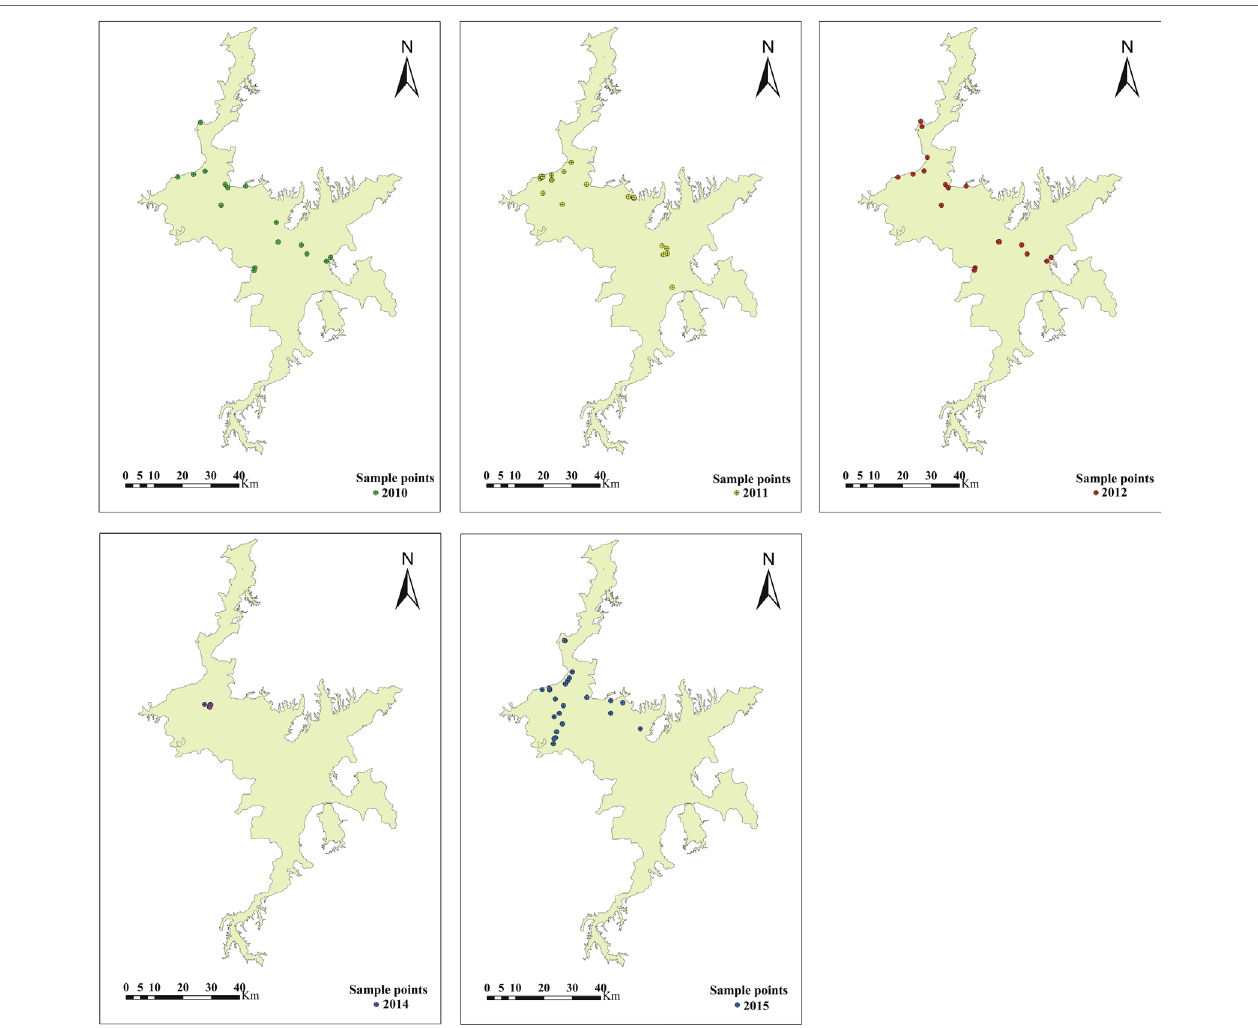
FIGURE 2 | Spatial distribution of sample points for model validation in 2010, 2011, 2012, 2014, and